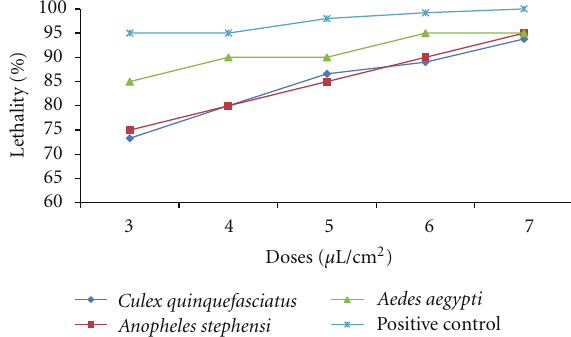
Figure 3: E ff ect of culture filtrates of Aspergillus niger against Culex quinquefasciatus , Anopheles stephensi and Aedes aegypti at di ff erent